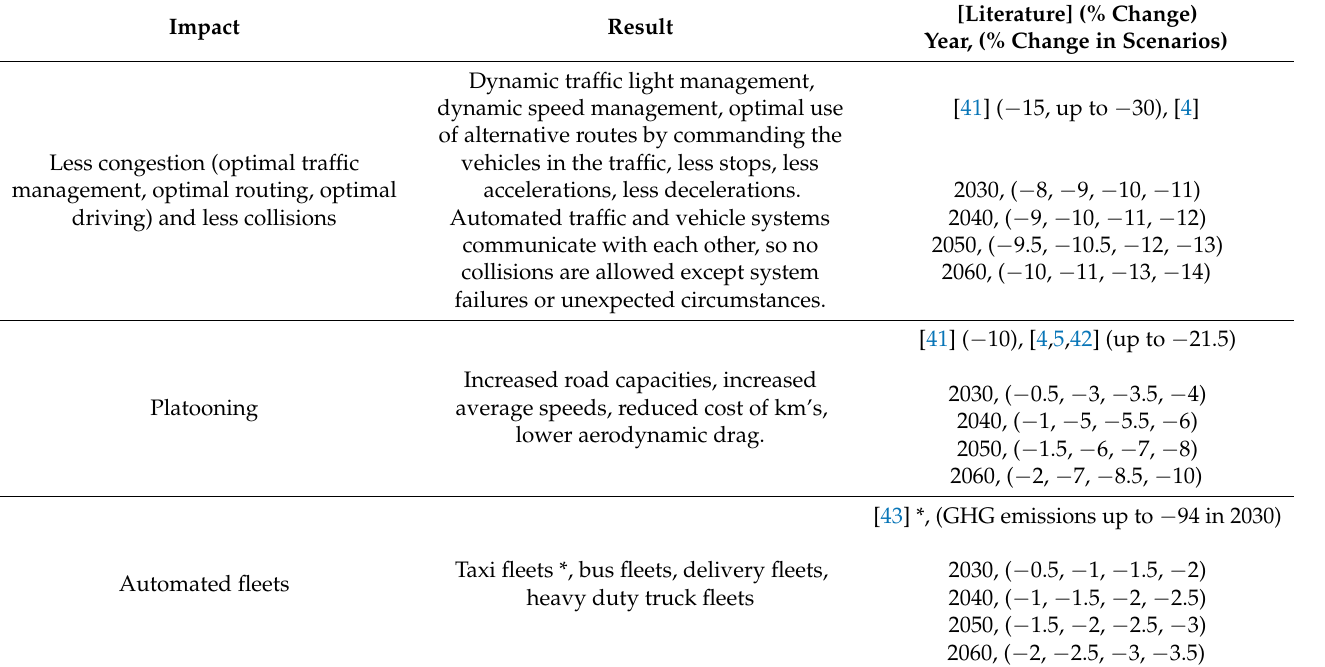
Table 5. Impacts of vehicle automation on road transportation energy-use.